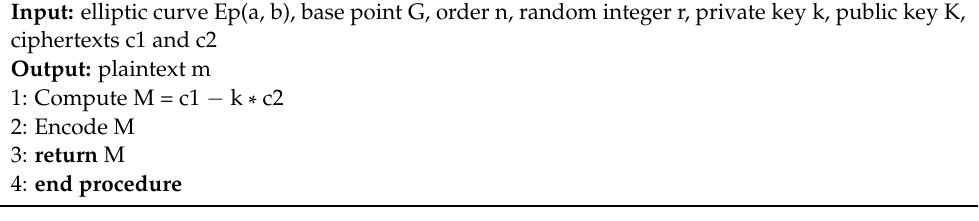
Algorithm 3 ECC decryption algorithm